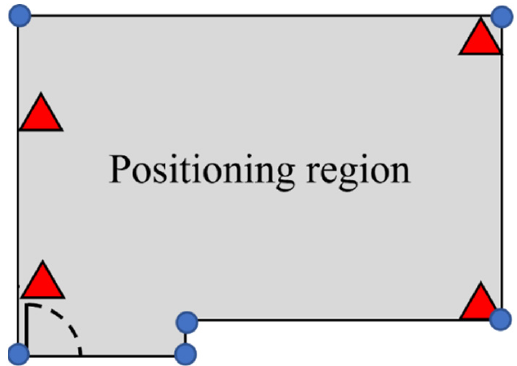
Figure 14. Region of a 2D